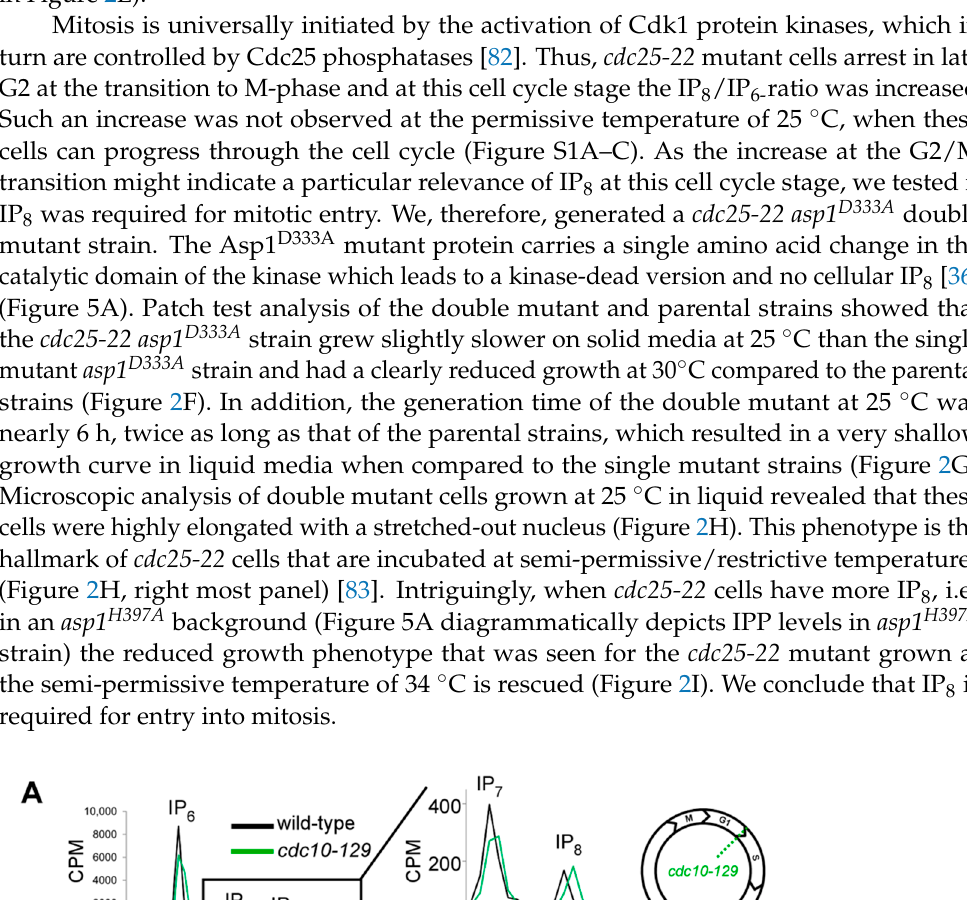
Figure 2. IP 8 is cell-cycle regulated and required for mitotic entry . ( A – C ) Typical HPLC profiles of soluble inositol phosphates and pyrophosphates extracted from cells that were arrested in ( A ) G1 ( cdc10-129) ; ( B ) metaphase-anaphase A transition ( cut9-665), and ( C ) G2/M boundary ( cdc25-22) compared to wild-type controls that were treated as the cdc strains. Boxed regions define the mag- nification of the IP 7 and IP 8 peaks shown on the right side. A schematic representation indicating where in the cell-cycle the indicated mutant arrests is shown in the right most panels. Wild-type and temperature-sensitive cdc strains were labeled with [ 3 H] inositol and pre-grown at 25 °C before a shift to 36 °C for 6 h prior to the soluble inositol extraction. Counts per minute (CPM). ( D ) Quan- tification of the IP 7 levels relative to IP 6 . Wild-type = 6.88 ± 0.72; cdc10-129 = 6.35 ± 0.79; cut9-665 = 6.48 ± 0.78; cut25-22 = 7.29 ± 1.31 ( E ) Quantification of the IP 8 levels relative to IP 6 . Wild-type = 2.12